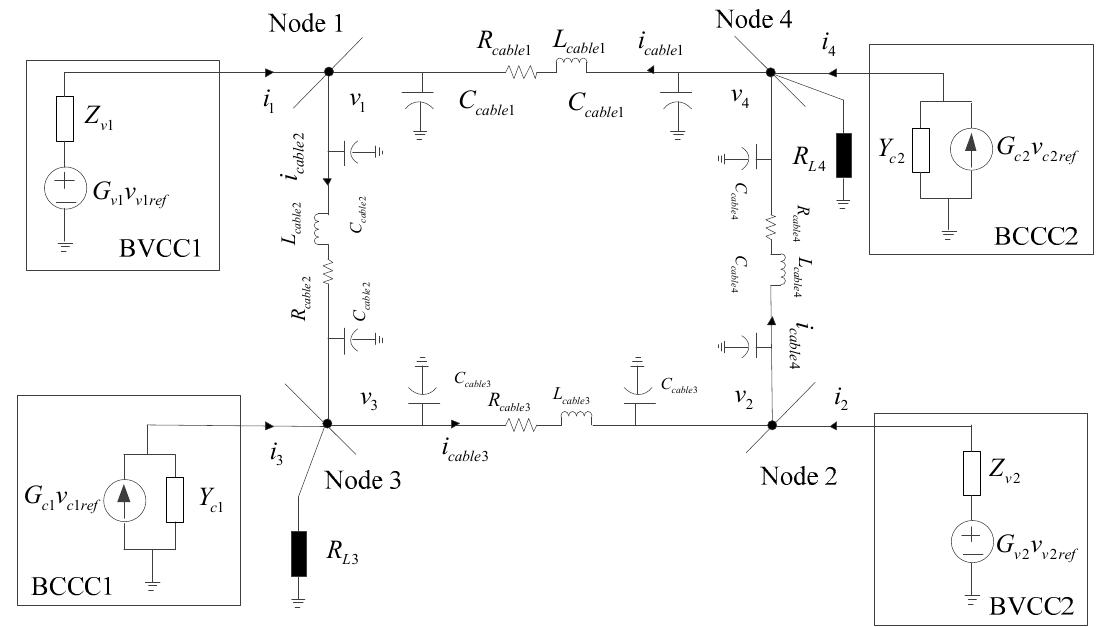
Figure 1. The block diagram of the component connection method (CCM) applied for the studied meshed DC distributed power systems (DPS).